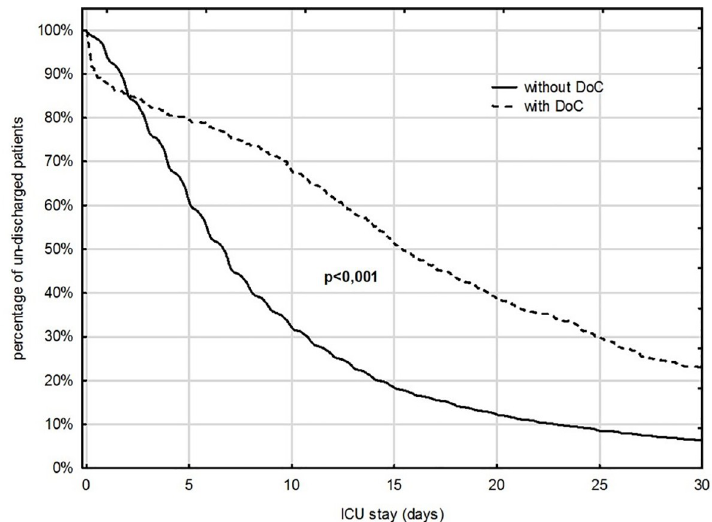
Fig 3. Kaplan-Meier curves presenting discharge curves in patients discharged from the ICU with and without DoC.